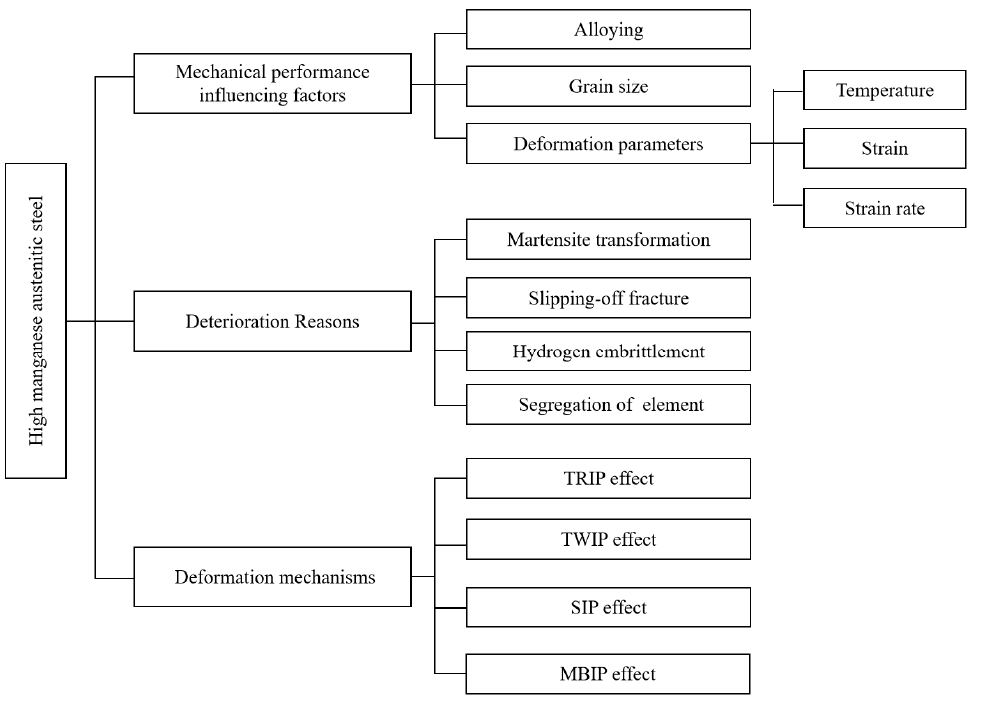
Figure 1. Structure of the current